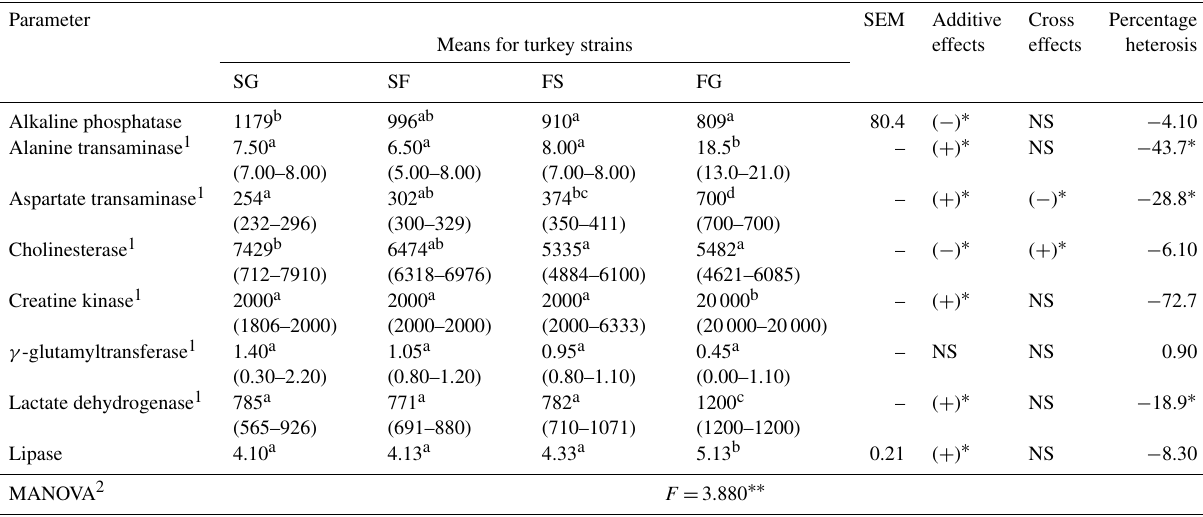
Table 3. Means, SEM or medians, lower and upper quartiles (in brackets), and orthogonal contrasts on enzyme activity in serum ( U L − 1 ) of female turkeys from different genetic groups.